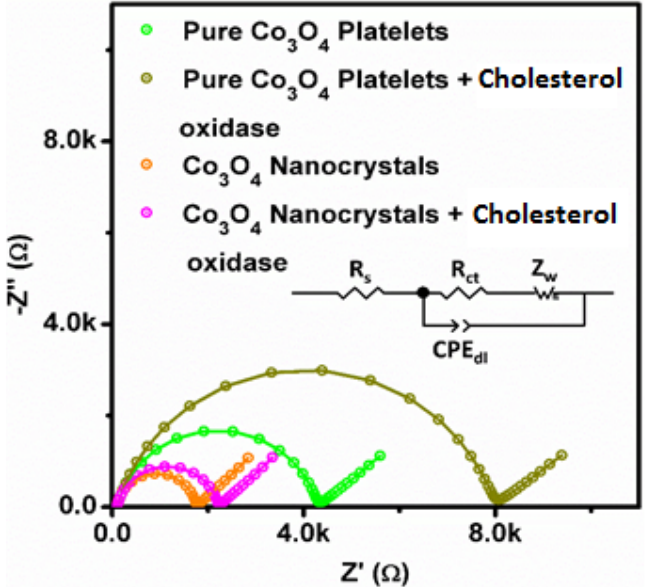
Figure 10. EIS analysis of Pure Co 3 O 4 platelets and Co 3 O 4 nanocrystals with and without cholesterol oxidase in 10 mM phosphate buffer solution of pH 7.3 containing 0.5 mM cholesterol. Table 3. Impedance values from EIS for various presented materials in this study.